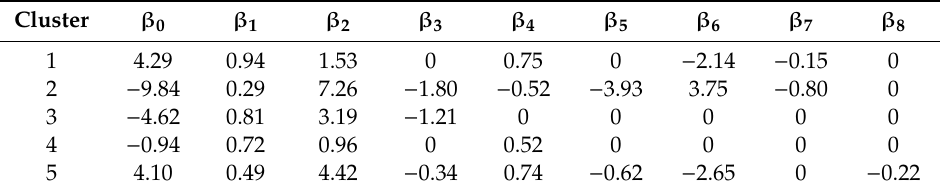
Table 9. Coe ffi cients of each variable for each cluster in the regression (Equation (16)) for design flood estimation.